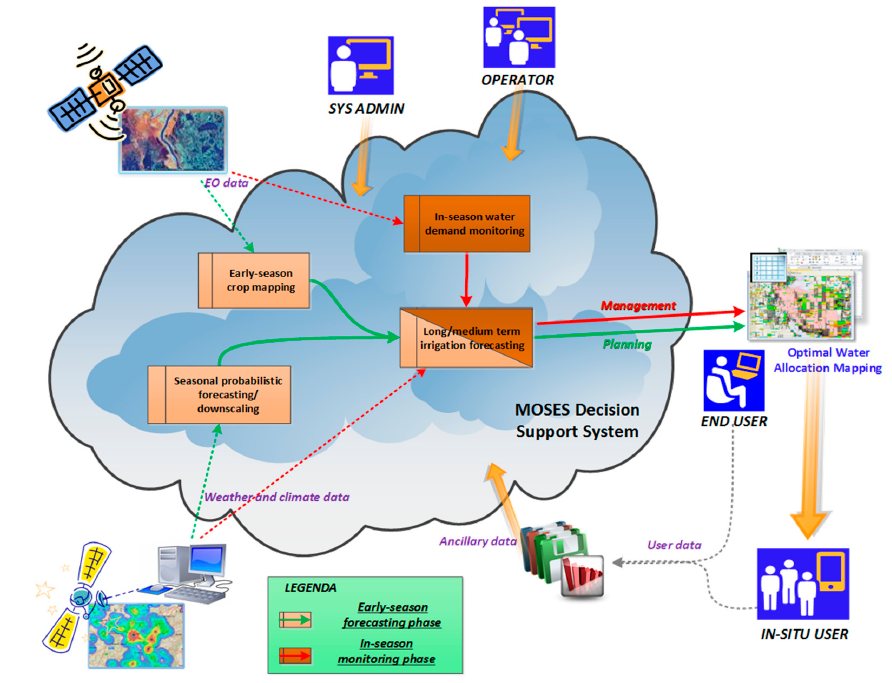
Figure 2. MOSES Decision Support System diagram.